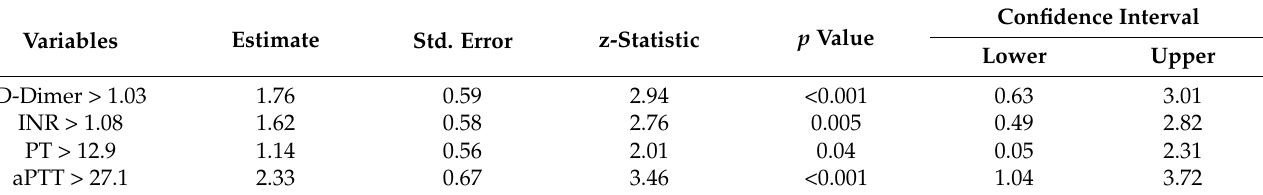
Table 3. Univariate binominal logistic regression